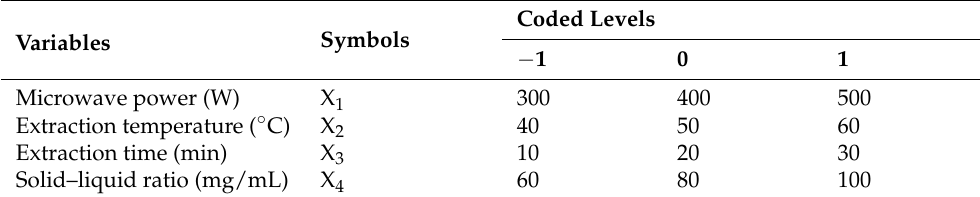
Table 2. The main variables and levels for BBD in this